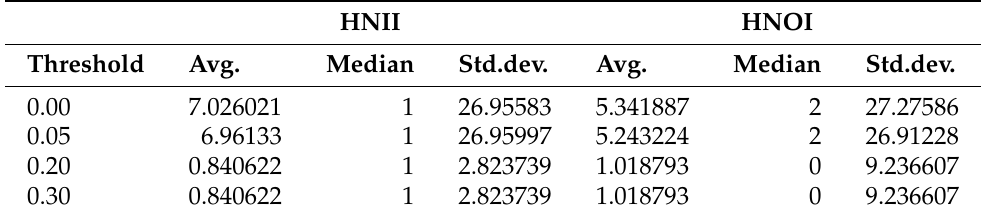
Table 1. Descriptive statistics of the HNII and HNOI (Hybrid Number of Incoming/Outgoing Invocations) metrics calculated using different